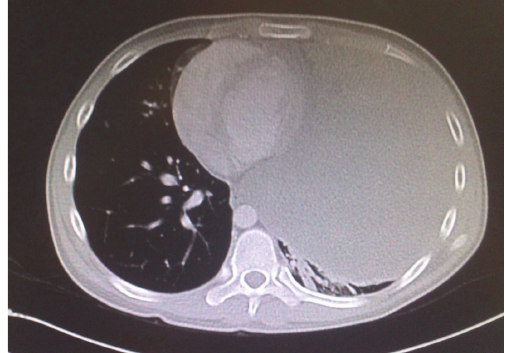
Figure 2: Anteroposterior view of CT scan showing that the mass occupies the whole of the left thoracic space.